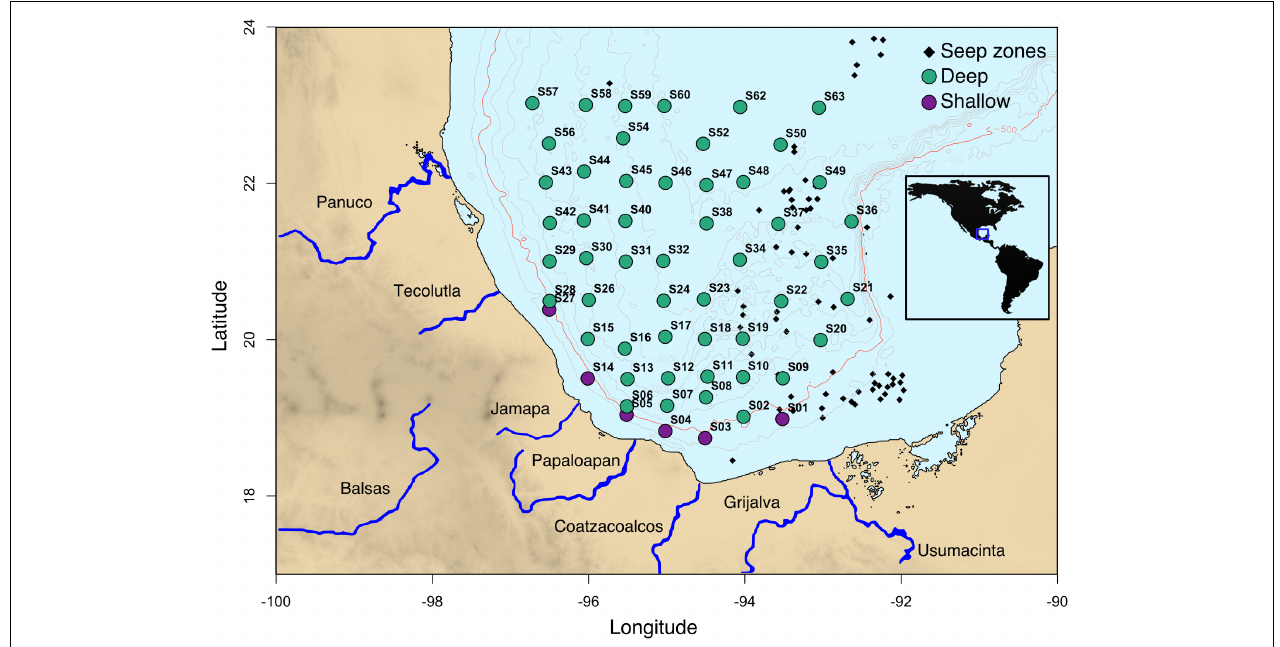
FIGURE 1 | Sampling locations in the swGoM. Sediments from depths less than 500 m are shown in purple and are considered shallow. The seeps distribution depicted in black squares was compiled using (MacDonald et al., 2015), Petroleos Mexicanos (PEMEX) data and locations obtained in field surveys (unpublished data). The red line indicates 500 m